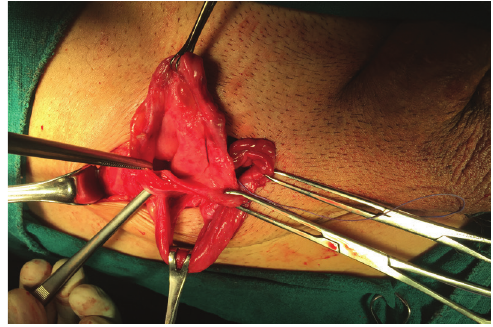
Figure 1: Showing congested small bowel loop as a content of the hernia sac.